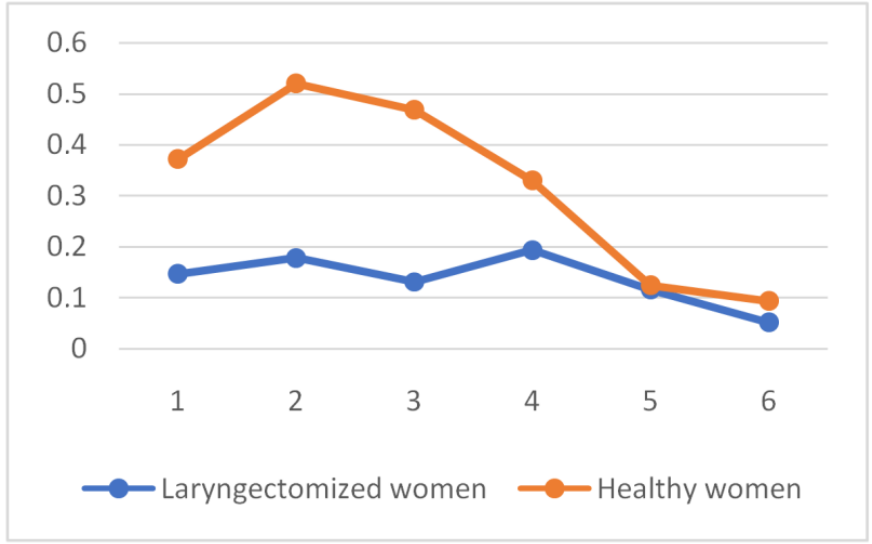
Figure 11. RMS feature distribution for the first phonetic segment of the word „barrel” (in Polish